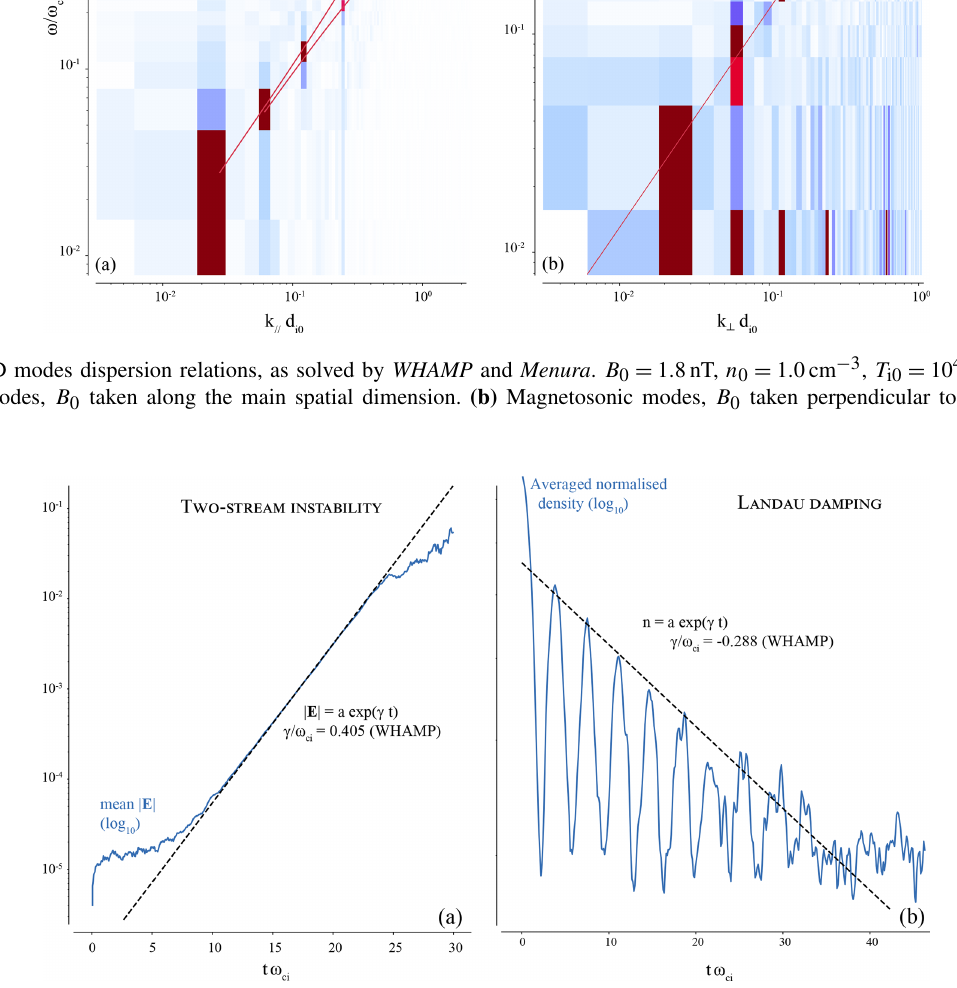
Figure 3. (a) Growth during the linear phase of the ion–ion two-stream instability; (b) Landau damping of an ion acoustic mode. Two- stream instability: B 0 = 1 . 8nT, n 0 = 1 . 0cm − 3 , T i0 = 10 2 K, T e0 = 10 3 K. Landau damping: B 0 = 1 . 8nT, n 0 = 5 . 0cm − 3 , T i0 = 1 . 5 × 10 4 K, T e0 = 10 5